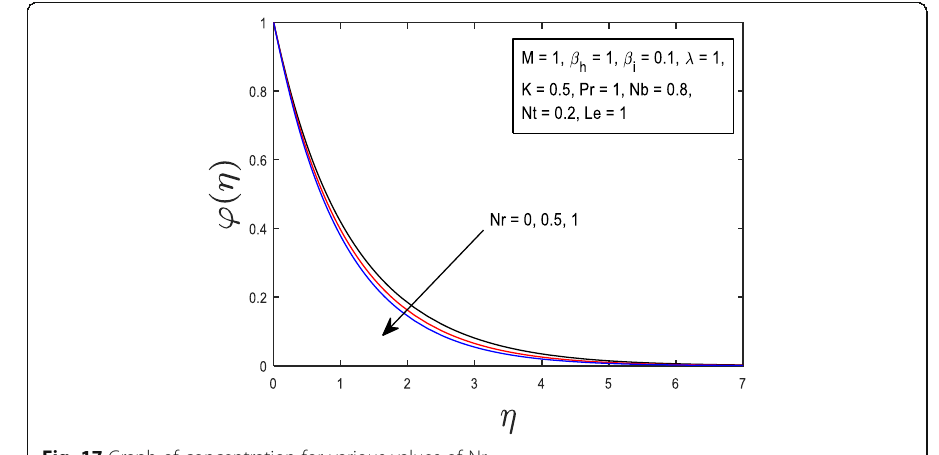
Fig. 17 Graph of concentration for various values of Nr